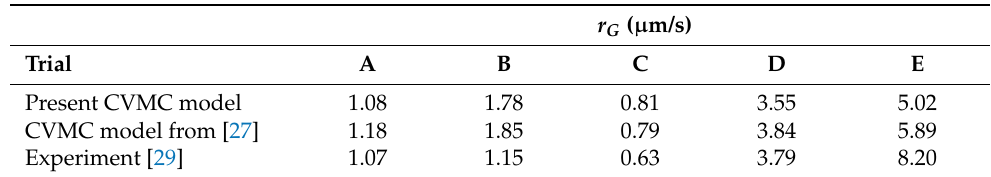
Table 3. The overall growth rate of different experiments and corresponding simulations by employ- ing the present CVMC model and the CVMC model from [27] after 10 min.